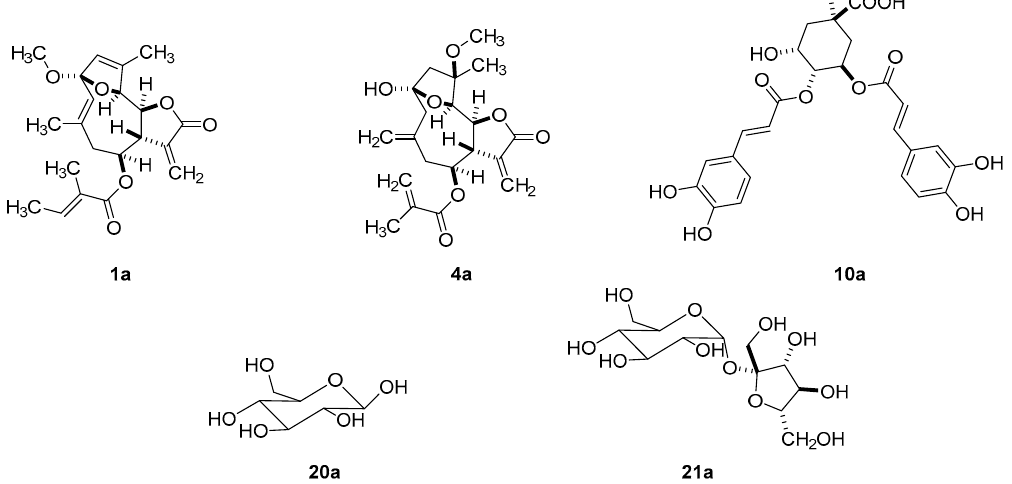
Figure 2. Dereplicated compounds in E. mollis whole crude methanol extract. 81